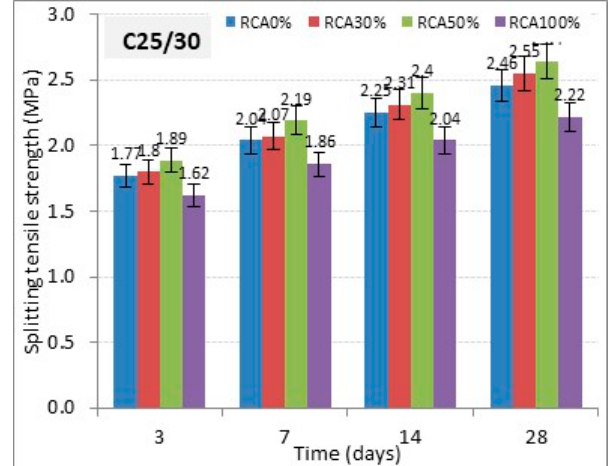
Figure 13. Effect of RCA content on the splitting tensile strength development for C25/30 concretes. Figure 13. E ff ect of RCA content on the splitting tensile strength development for C25 / 30 concretes.